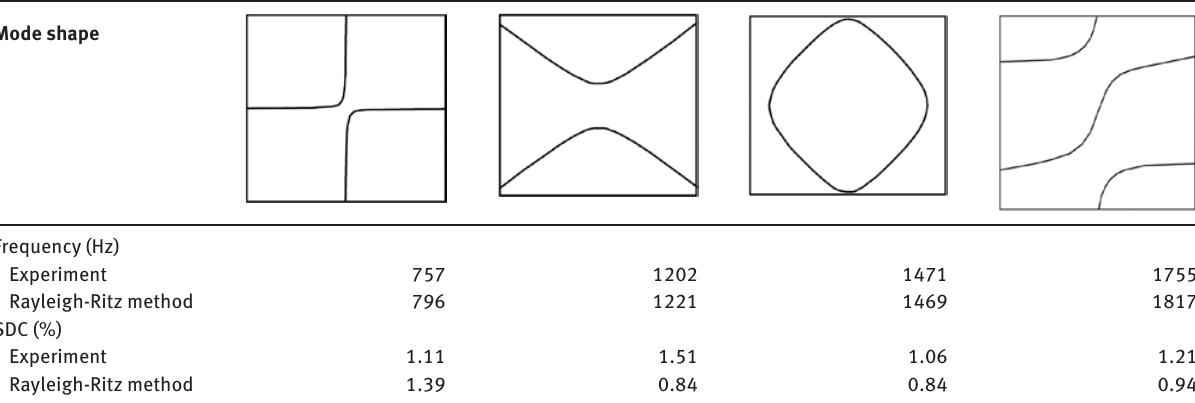
Table 1: In vacuo modal data of an all-free, [− 60, 0, 60] CFRP/Al honeycomb sandwich panel, cited from Ref. [5].